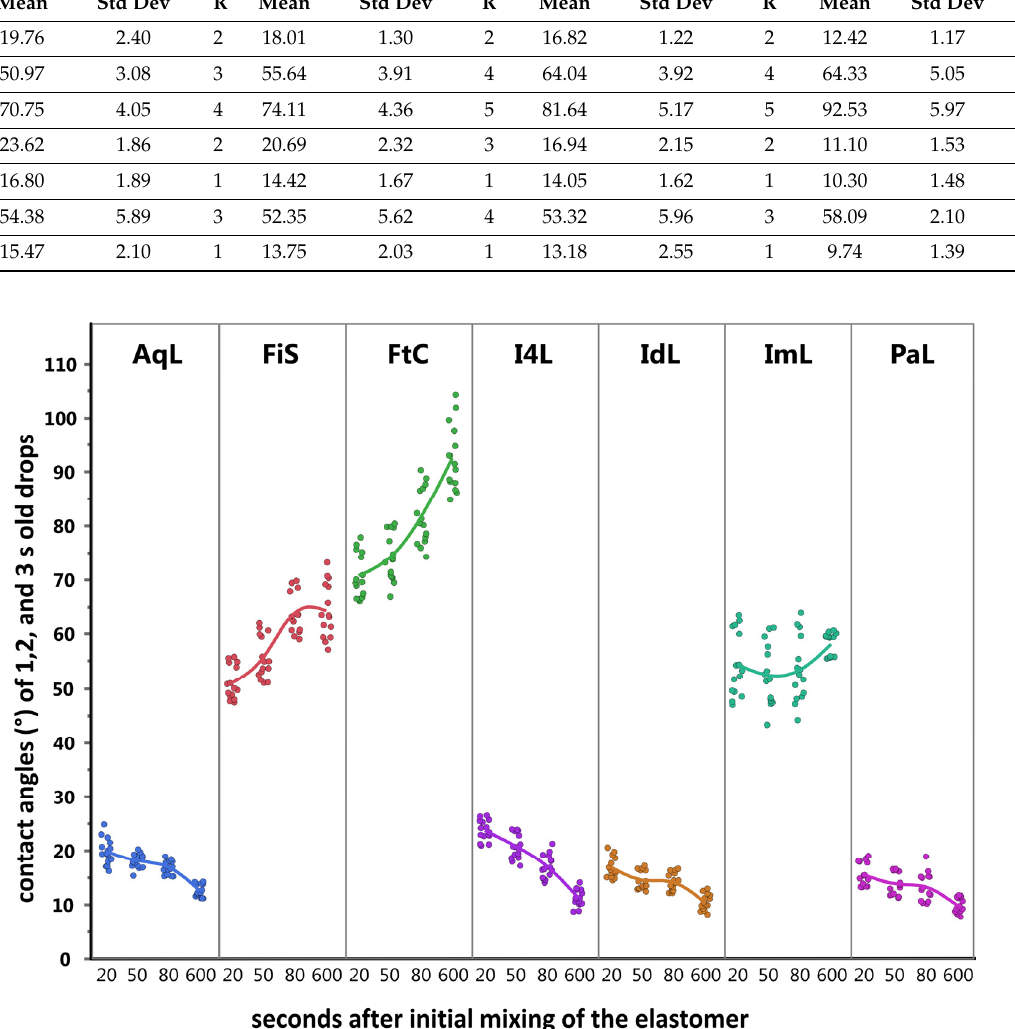
Figure 9. Wettability behavior over time. Three measured contact angles (y-axis) met at the polymerizing light-body materials after initial mixing (x-axis). Each dot gave one angle measurement at the drop. Scattering of the dots offered insight into spreading behavior of the drop from 1 to 3 s (15 measurements from 5 specimens per group).